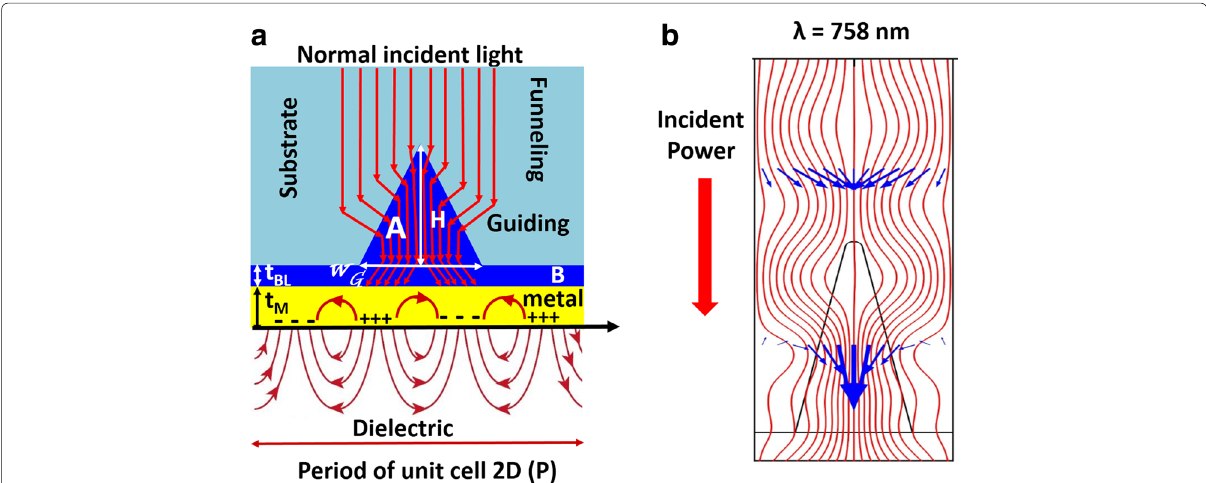
Fig. 1 a Schematic diagram of the proposed structure and b time-averaged power flow at λ = 758 nm for the proposed structure without the metal layer where the funnelling mechanism is